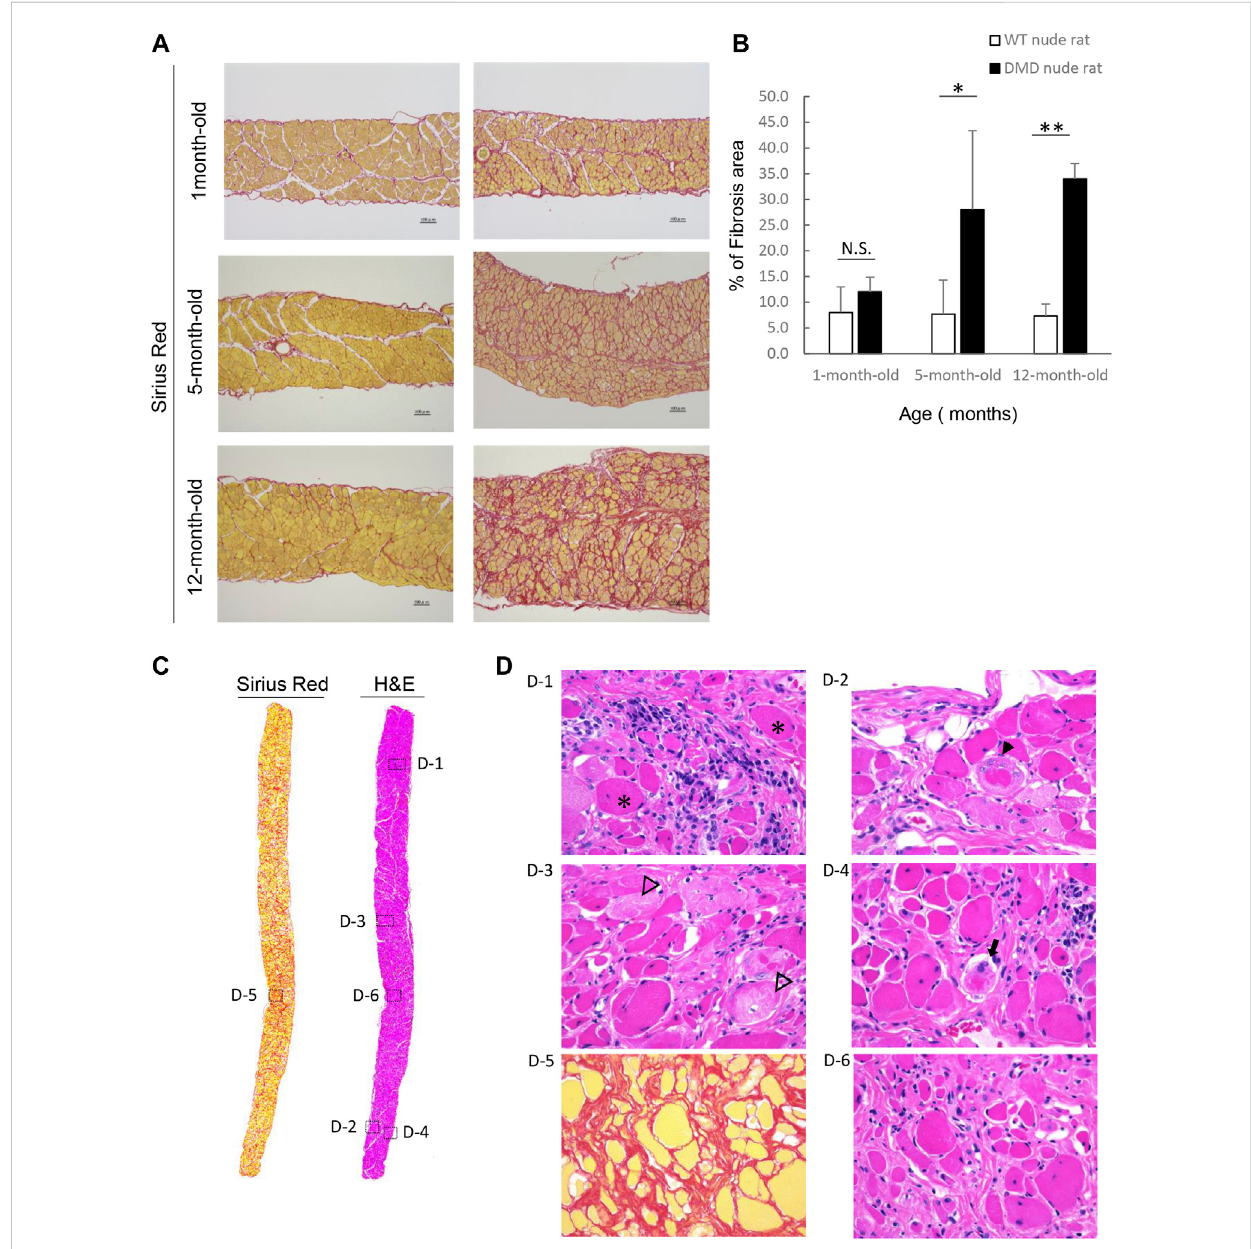
FIGURE 4 Detailed analysis of severe changes in the diaphragm in DMD nude rats. (A) Representative Sirius red (SR)-stained images of the detailed analysis of severeandprogressivechangesinthediaphragminDMDnuderats.Theleftrowshowstheresultsfromwildtype(WT)nuderats,andtherightrowshows the results from DMD nude rats. Scale bar = 100 µm. (B) Bar graph summarizing SR-positive areas in thediaphragm from rats at1, 5, and over 12-month- old. N.S. non-signi fi cant, ** p < 0.01. (C) Representative images of SR and hematoxylin & eosin (H&E) staining showing the degree of fi brosis in the diaphragm of a DMD nude rat. The right row shows H&E staining, and the left row shows SR staining. (D) Representative images of H&E staining of the diaphragm of 12-month-old DMD nude rats. Magni fi ed area denoted by the square in panel (C) . The symbols, *, ▼ , ▽ , and ➡ , indicate hypercontraction (opaque) fi ber (D-1), ring- fi ber (D-2), pale necrotic fi ber (D-3), and moth-eaten fi ber (D-4), respectively. Comparative images of H&E and SR staining of the same location are shown (D-5 &